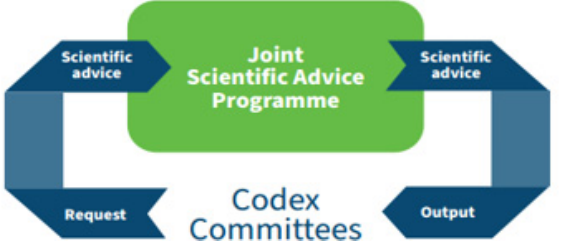
Figure 1. Information flow between JEMRA and the Codex Committee on Food Hygiene (CCFH).